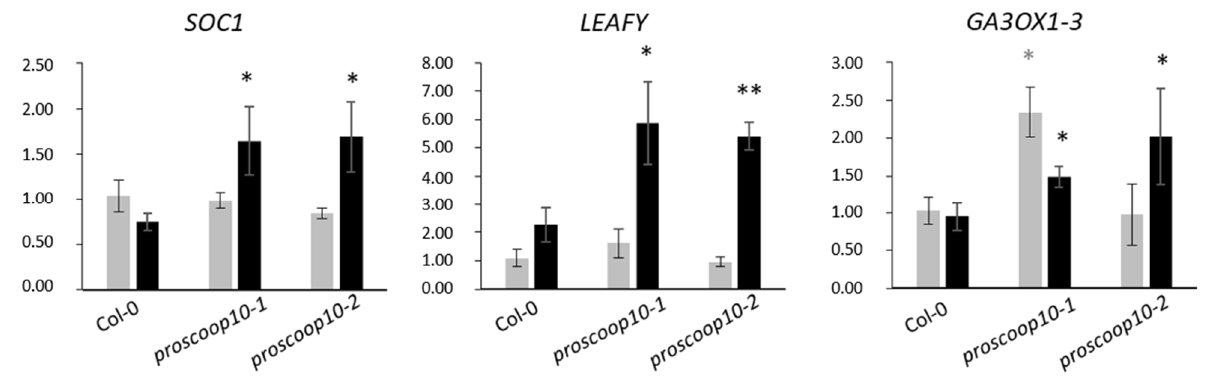
Figure 6. Impact of PROSCOOP10 mutation on transcription of genes involved in floral regulation. Relative expression of SOC1 , LEAFY and GA3OX ‐ 1 genes was measured by RT ‐ qPCR after 7 days (in grey) and 11 days (in black) in the two proscoop10 mutant lines compared to Col ‐ 0 at 7 days. Values represent mean ratios ± SEM of three independent biological replicates. Asterisks denote statistical differences in gene expression levels between prosccoop10 mutants and Col ‐ 0: * p < 0.05, ** p < 0.01 (ratio ‐ paired t ‐ test).